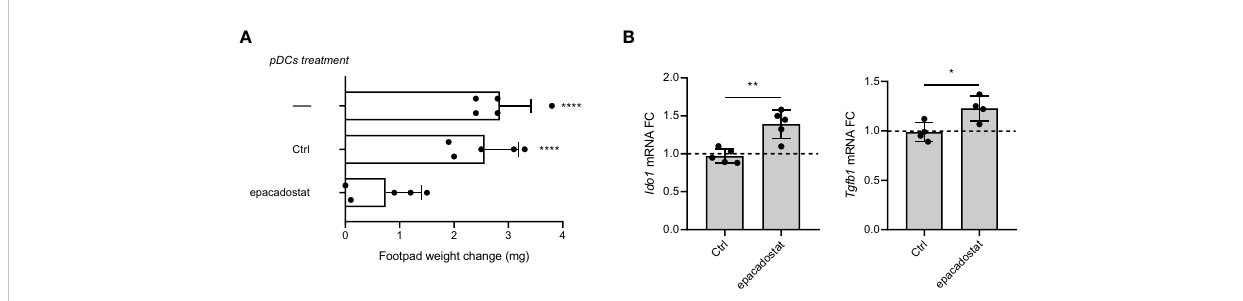
FIGURE 4 Epacadostat confers a tolerogenic phenotype on pDCs. (A) Skin test reactivity of mice sensitized with splenic HY ‐ pulsed immunostimulatory cDCs combined with a minority fraction (5%, indicated) of pDCs. pDCs were left untreated, treated with the vehicle DMSO (Ctrl) or stimulated with epacadostat 1 m M prior to be HY-pulsed together with cDC majority fraction and i.p. transferred into syngeneic C57BL/6 recipient female mice. Two weeks after the immunization, mice were assayed by footpad challenge with HY peptide. Skin test reactivity of the recipient mice (n=6 per group) to the eliciting peptide is represented as change in weight of treated footpad vs vehicle ‐ receiving counterpart. Data are reported as mean value ± S.D. of three experiments. (B) Real ‐ time PCR analysis of Ido1 and Tgfb1 transcripts. Data (means of three experiments using triplicate samples) represent the Ido1 and Tgfb1 transcript fold change in 1 m M epacadostat – treated relative to untreated pDCs, all normalized to the Gapdh expression. Dotted line, fold change = 1. Data are reported as mean value ± S.D. of three experiments. Data in (A) are presented as change in footpad weight and signi fi cance is referred to a Tukey ’ s multiple comparison test (n=6 mice/group for (n=3)) ****P< 0.0001. Data in (B) were analyzed with Unpaired Student ’ s t-test. *p< 0.05, **p<